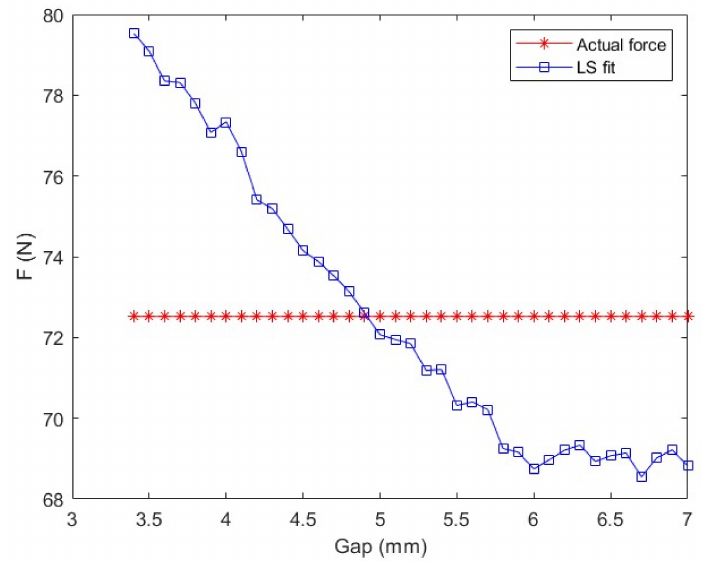
Figure 6. Comparison of the actual electromagnetic force and the electromagnetic force estimated by Equation